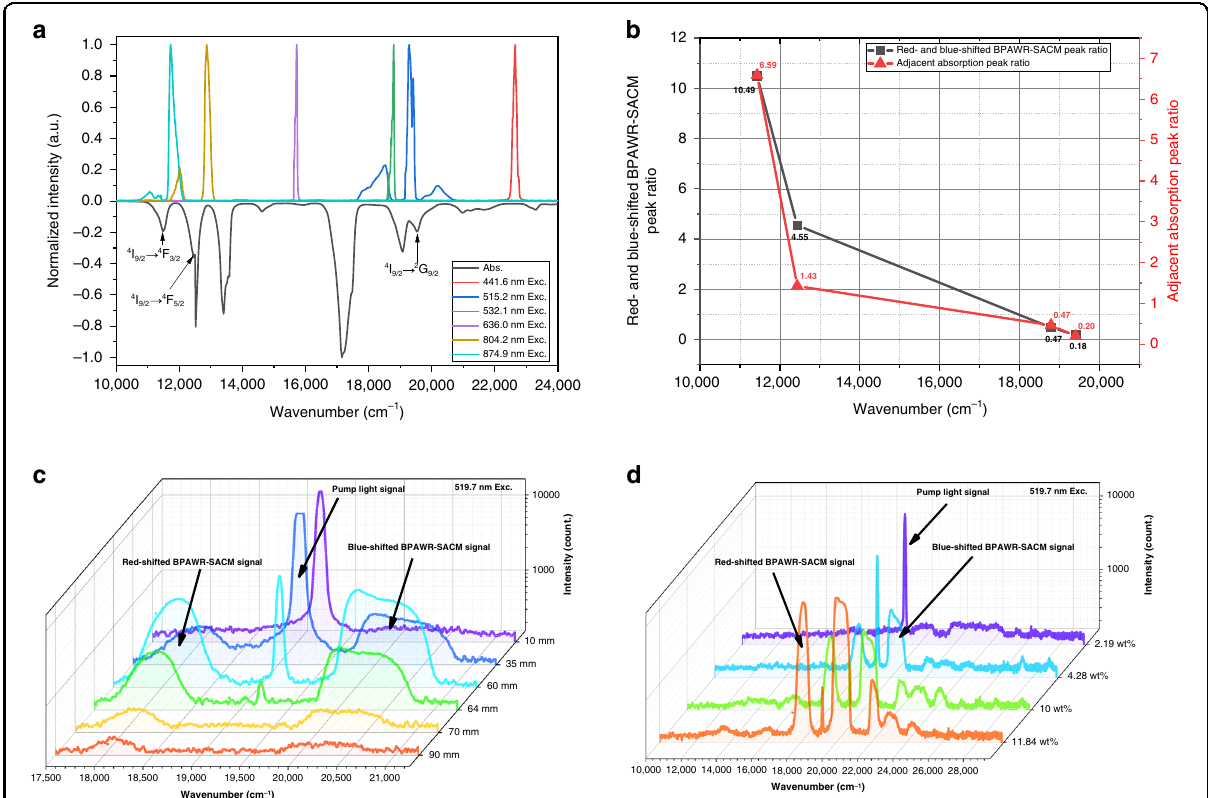
Fig. 3 Modulation results of BPAWR-SACM process based on absorption characteristics. a Normalized emission spectra at different excitation wavelengths (upper part) and normalized absorption spectrum in the visible light range (lower part). Corresponding excited energy levels are marked in the fi gure. b Statistical results of the red-shifted and blue-shifted BPAWR-SACM peak area ratio versus the adjacent absorption peak area ratio. All relevant excited states within phonon frequency of 3000 cm − 1 were considered in the statistics. c Emission spectra were measured by 519.7 nm excitation at samples with different lengths. d Emission spectra of samples with different doping concentrations excited by 519.7 nm laser. The intensities in c , d were presented in logarithm to observe relatively weak emission